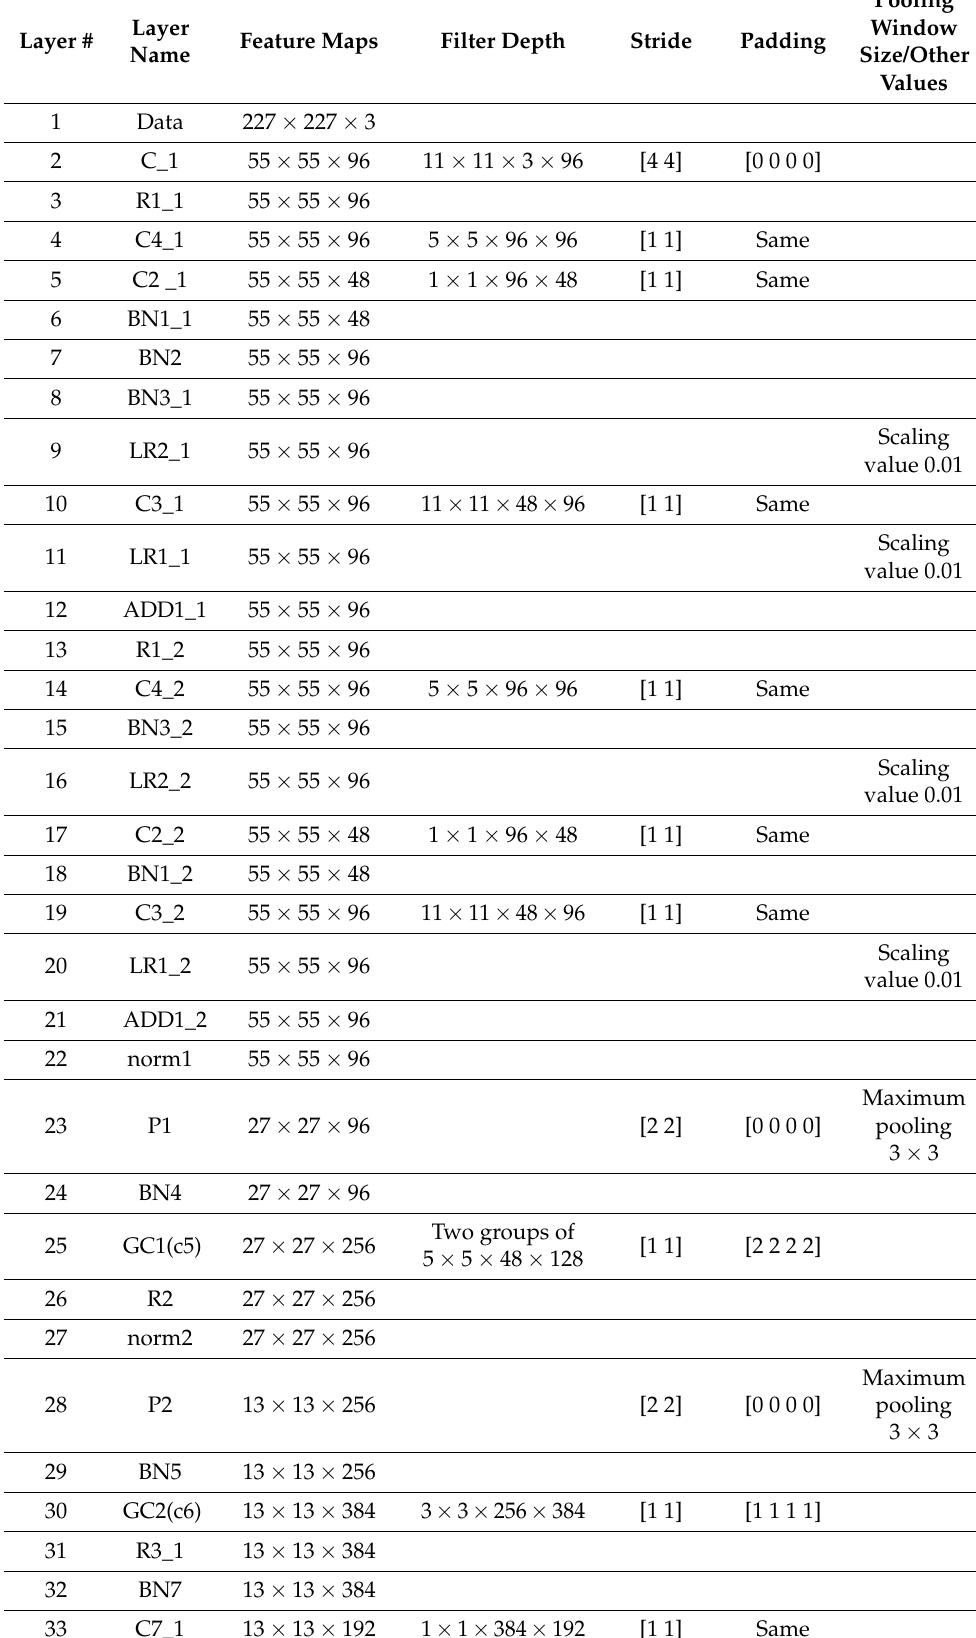
Table 1. Configurations of layers of proposed model